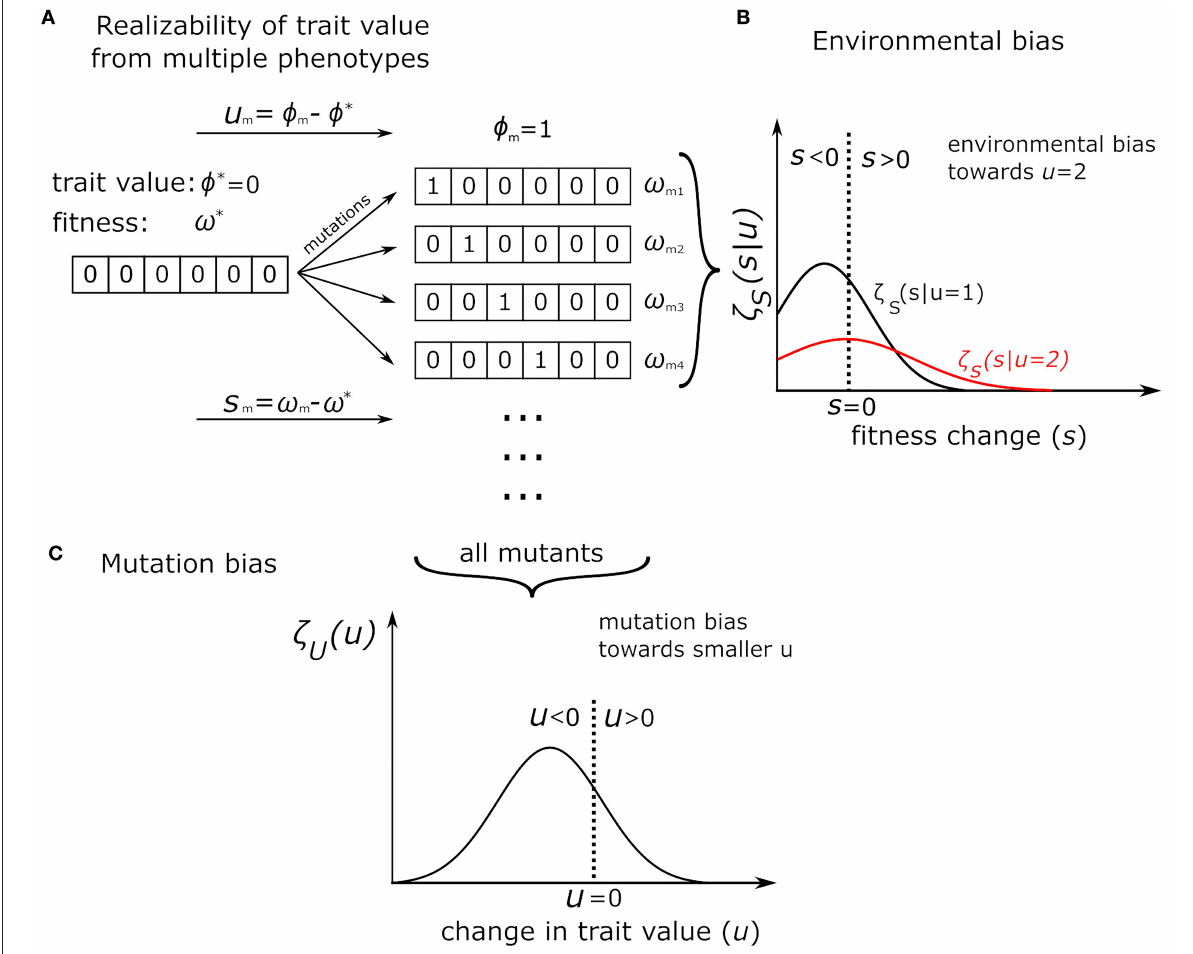
FIGURE1 Illustration of multiple-realizability using the NK model. Organisms are strings, the trait value φ is the sum of the string. See text for more details. (A) Shows a wild type that mutates into a group of different mutants, all with the same trait value ( φ m = 1), but different fitnesses ( ω m ). This population of mutants then form a density distribution [ ζ , (B) ] of fitnesses, with density on the y-axis and s = ω m − ω ∗ (fitness difference from wildtype) on the x-axis. As drawn, mutants with trait value 2 has higher average fitness than mutants with trait value 1 (red line). (C) We have another density distribution, of all possible mutants of the wildtype (rather than all mutants with the same trait value), now over u (the change in trait value) rather than over s . This distribution illustrates mutation bias. As illustrated, there is a mutation bias toward smaller trait value ( u <